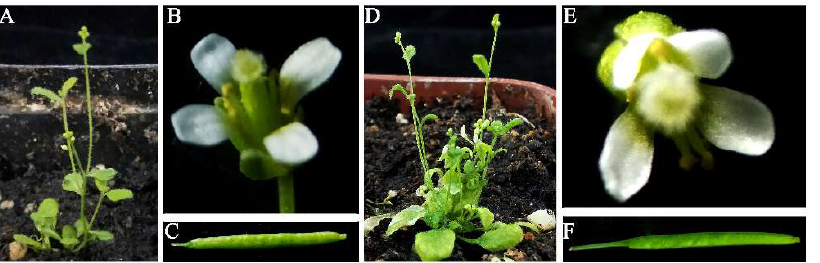
Figure 5. Phenotypes of floral organs in PtoNF-YC6 transgenic Arabidopsis . ( A ) WT plants. ( B ) WT petals. ( C ) WT seeds. ( D ) PtoNF-YC6 gene transgenic plants. ( E ) PtoNF-YC6 transgenic plant petals. ( F ) PtoNF-YC6 transgenic plant seeds.